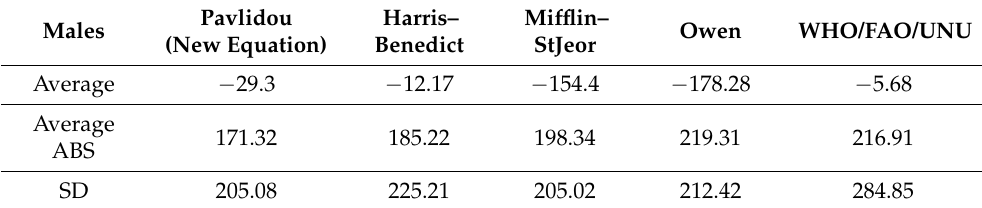
Table 5. Difference RMR P -RMR IC in Males.